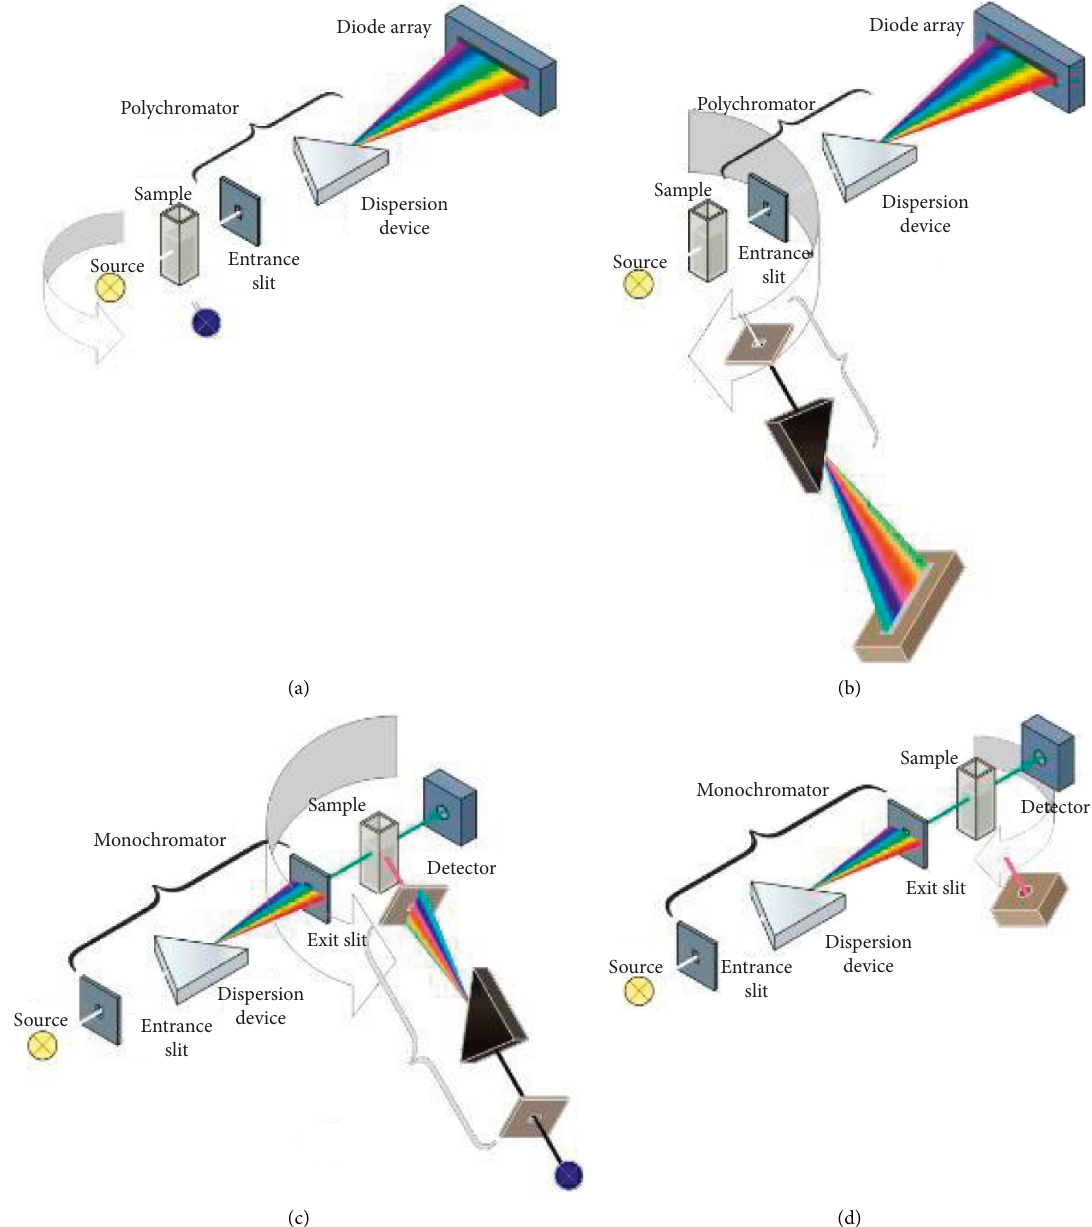
Figure 2: Scattered light is gathered by three revolving prisms, which route the scattered light to the detector. Devices are designed with a central pattern in mind